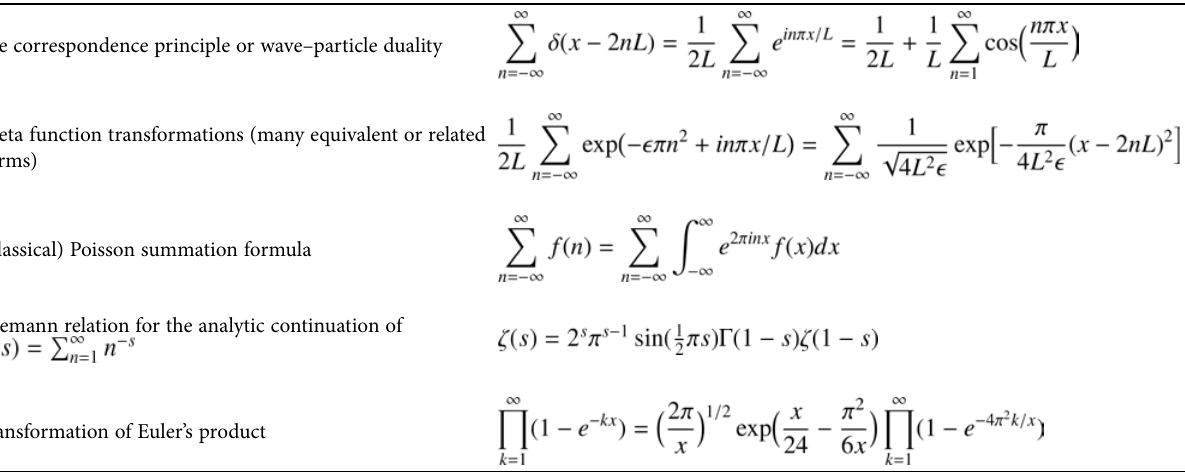
Table 1. Five essentially equivalent results, identifiable as a single theme that is central to a broad range of problems in classical and quan- tum